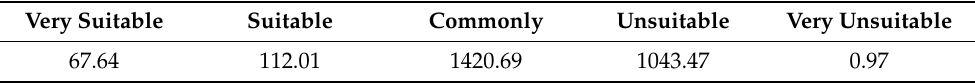
Table 4. The area of the same category by Choquet fuzzy integral method and Sharpley value (km 2